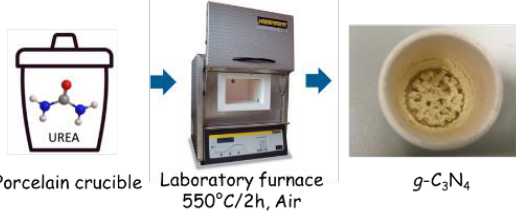
Figure 1. The obtained light yellowish bulk of g -C 3 N 4 .